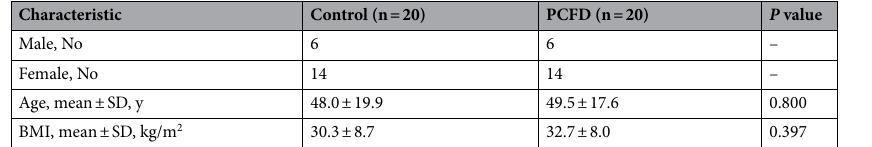
Table 1. Patient demographics of progressive collapsing flatfoot deformity and control patients. BMI body mass index, PCFD progressive collapsing foot deformity, – no entries.